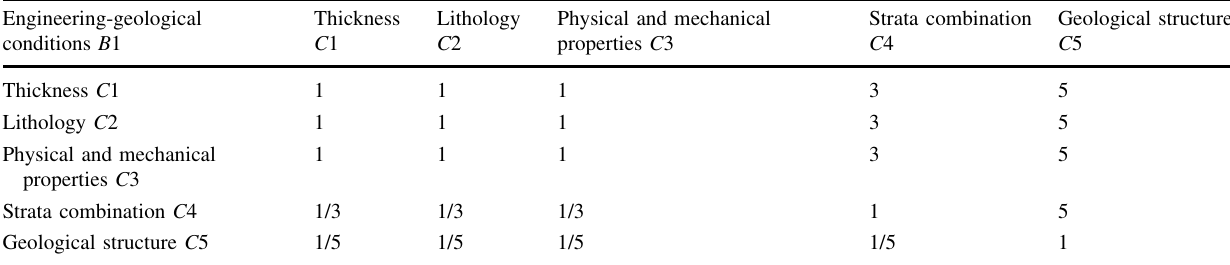
Table 1 Evaluation table of the relative